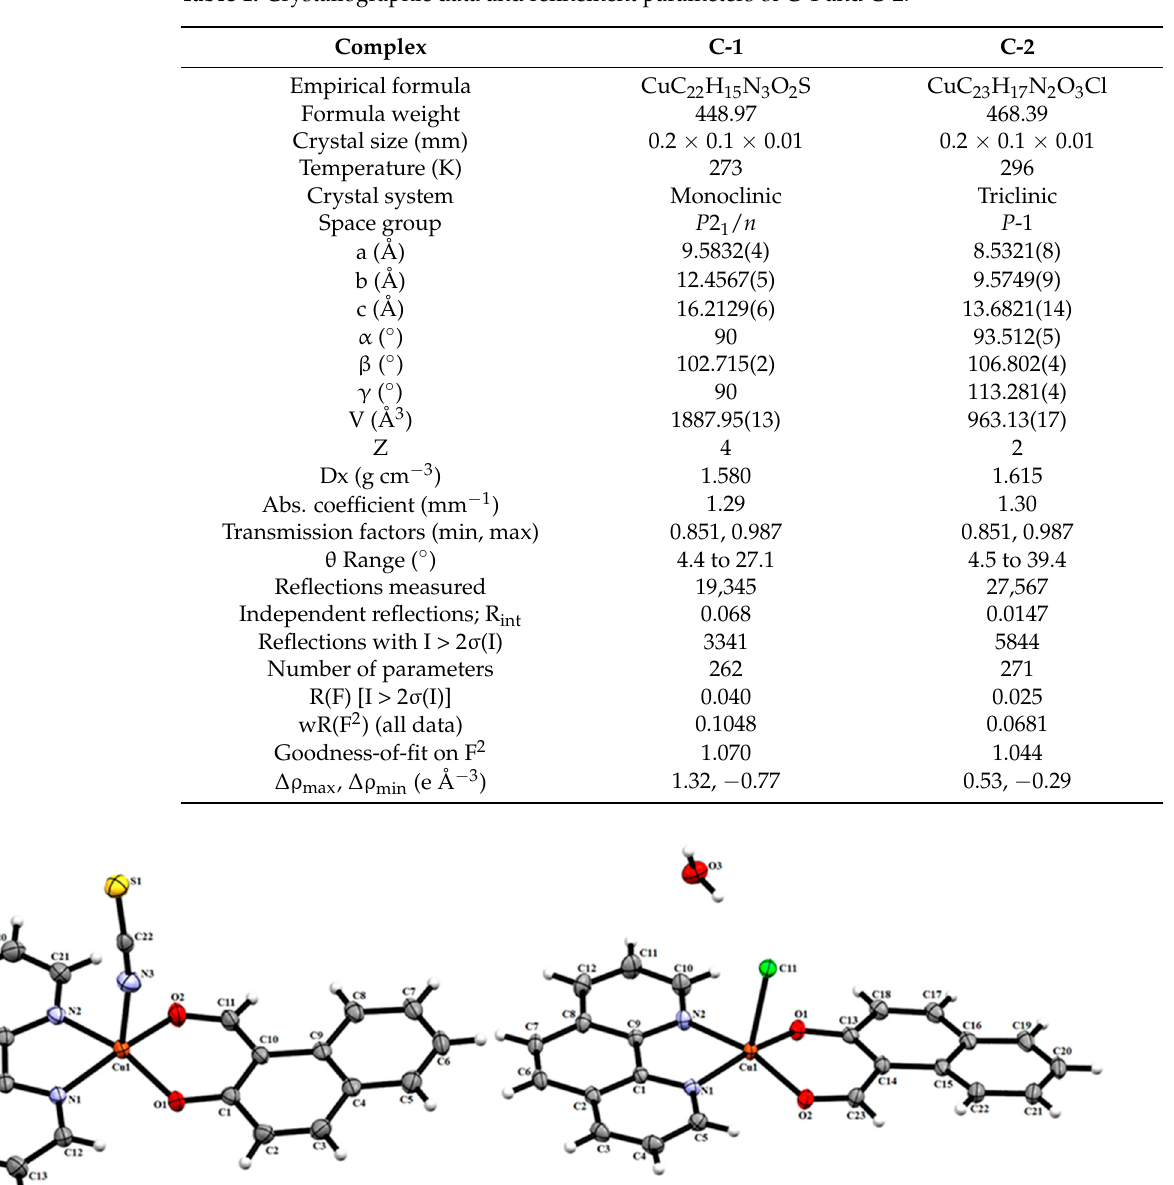
Table 1. Crystallographic data and refinement parameters of C-1 and C-2.